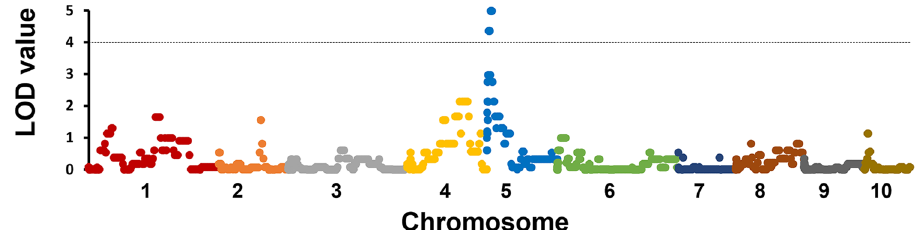
Figure 2. Manhattan plot for the single marker analysis of 982 SNPs and the anthracnose resistance response of a representative subset (i.e. BIN Map) of 21 recombinant inbred lines (RILs) derived from the crosses between IS18760 and PI609251 evaluated in the greenhouse against the pathotype AMP-048 from Arkansas, U.S.A. Horizontal dashed line marks significance threshold based on 1000 permutations ( P <